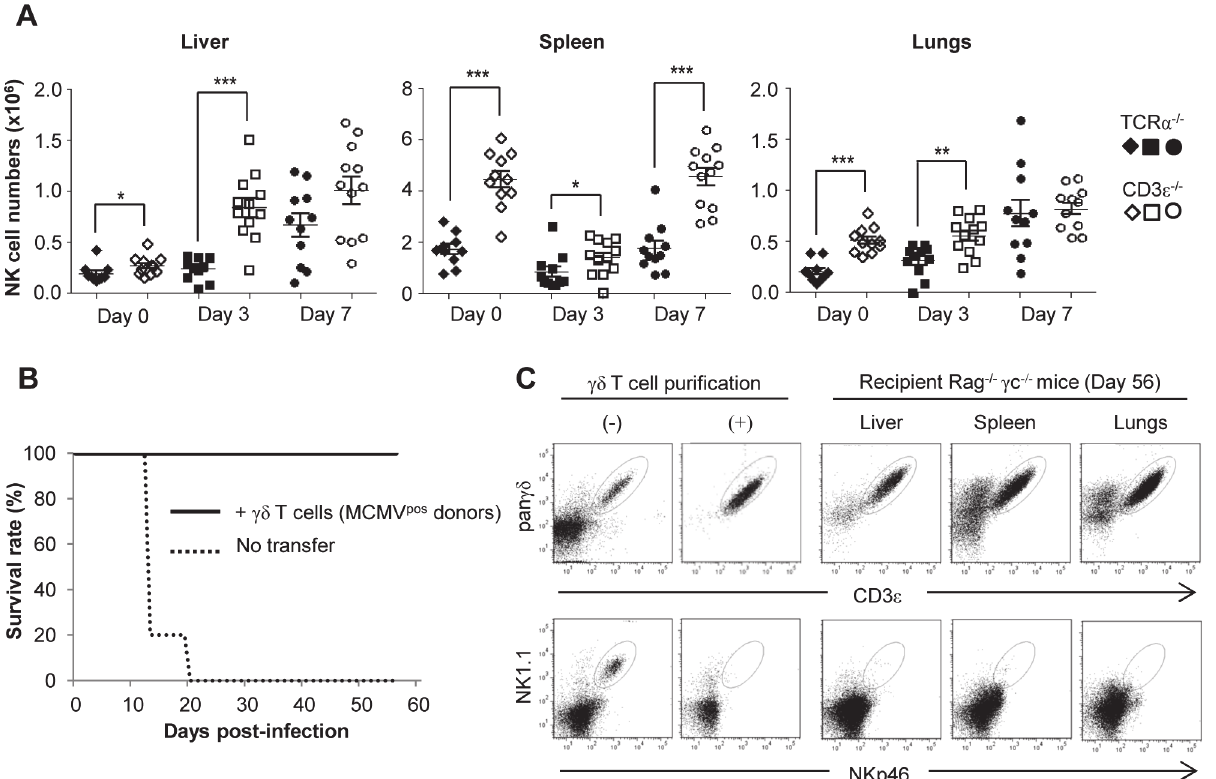
Fig 8. NK-independent antiviral protective effect of γδ T cells. A. TCR α − / − and CD3 ε − / − mice were uninfected(Day 0) or infected i.p. with 2.10 3 PFU of MCMV. At indicated days post-infection, 5 – 6 mice were sacrificed and immunecells were isolated fromeach organ for flow cytometry analysis. Absolute numbers of NK cells were calculated as describedin methods. Black and white symbols represent individual TCR α − / − and CD3 ε − / − mice respectively, and horizontallines represent the mean of 10 – 12mice pooled from2 independent experiments. Differences were evaluatedusing theMann-Whitney test: * = p < 0,05, ** = p < 0,01, *** = p < 0,001. B. γδ T cells from 14-days infected TCR α − / − mice were purified and i.v. transferred (1.10 6 cells, 97% purity) into Rag − / − γ c − / − mice (10 recipients). 24h after transfer, reconstitutedRag − / − γ c − / − mice were challenged with 2.10 3 PFU of MCMV and monitoreddaily for mortality. 5 untransferred Rag − / − γ c − / − mice were usedas controls. Results are fromone representative of 2 independent experiments. C. Left: flow cytometry analysis of live (7AAD − ) CD3 ε + pan γδ + T cells (upper panels) and NKp46 + NK1.1 + cells (lower panels) insplenocytes fromTCR α − / − donors, before (-) and after (+) purificationof γδ T cells as describedin methods. Right: At day 56 post-infection of Rag − / − γ c − / − recipients, 3 mice were sacrificed; organs removedand immune cells isolated for flow cytometry analysis of γδ andNK cells. Results are from onerepresentative mouse.